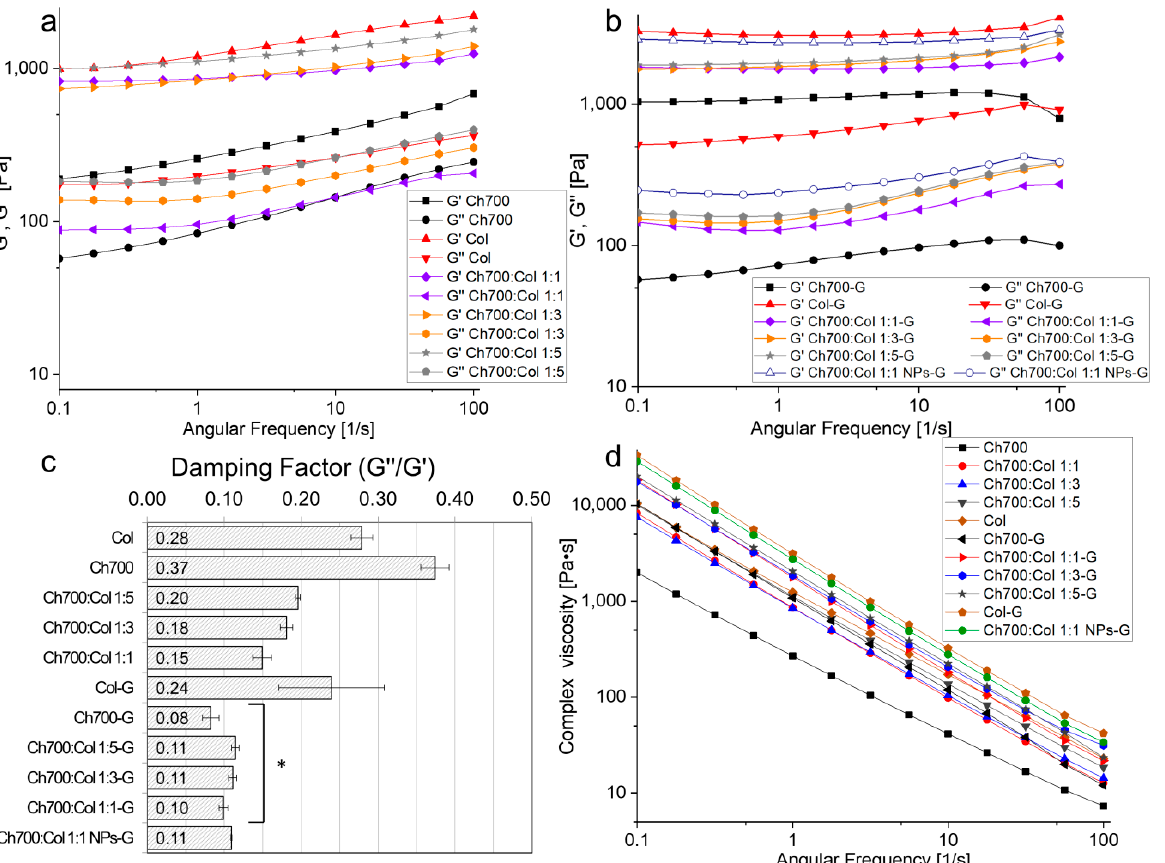
Figure 5. Viscoelastic behavior of different hydrogels. ( a ) Dependence of G’ and G” moduli as functions of angular frequency for gels without genipin. ( b ) Dependence of G’ and G” moduli as functions of angular frequency for genipin-added gels. ( c ) Damping factor at an angular frequency of 10 rad/s, *— p < 0.05 vs. uncross-linked gels. ( d ) Complex viscosity of hydrogels as a function of angular frequency.